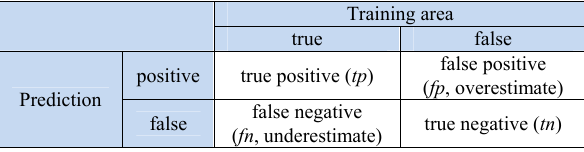
Table 1. Relationship between prediction and training area